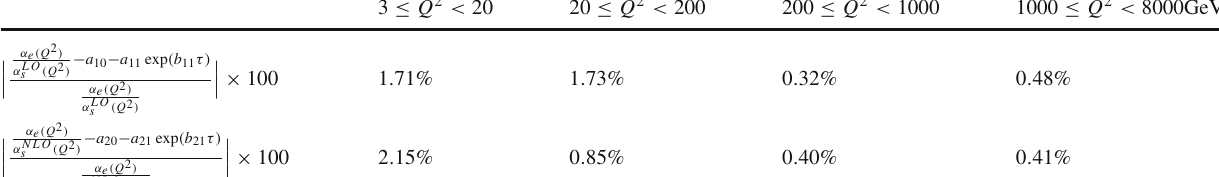
Table 1 The percentage relative errors of exact and approximate values of Eqs. (26)–(28) 3 ≤ Q 2 < 20 20 ≤ Q 2 < 200 200 ≤ Q 2 < 1000 1000 ≤ Q 2 < 8000GeV